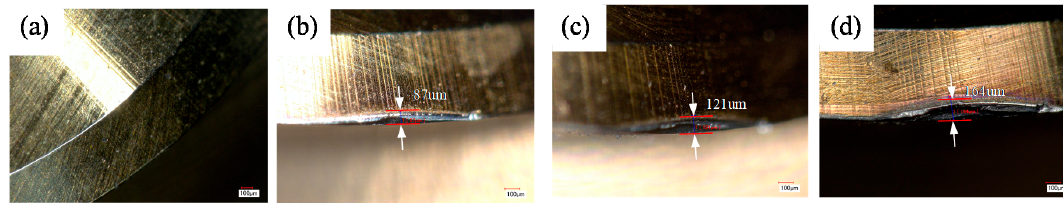
Figure 7. Experimental site ( a ) cutting process; ( b ) the collection of vibration data; ( c ) measurement of tool wear; ( d ) measurement of surface morphology.